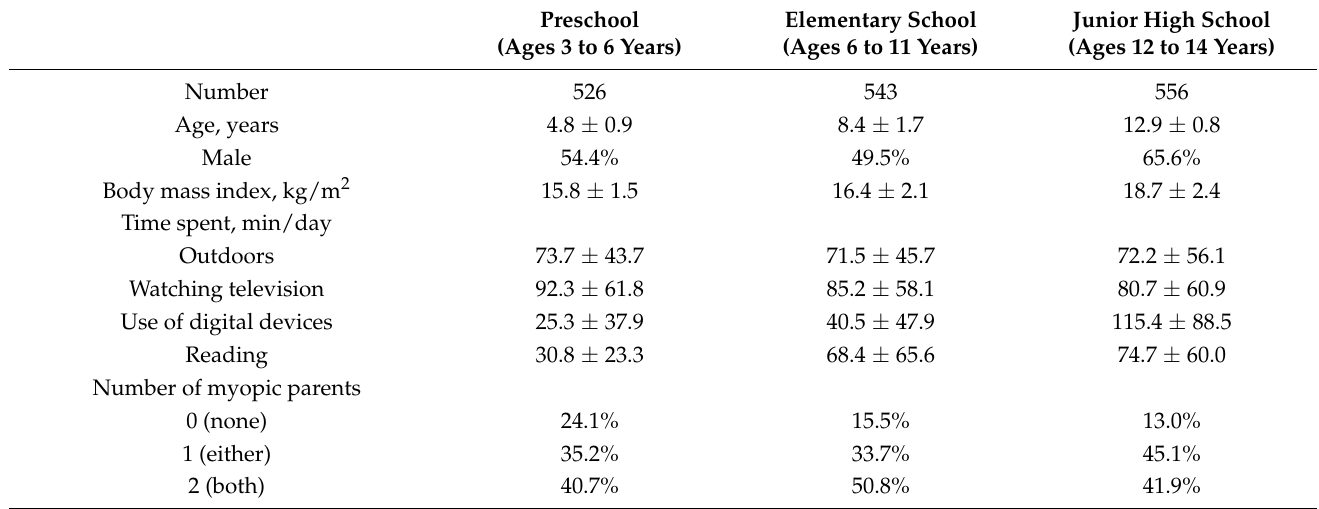
Table 2. Lifestyle characteristics based on school groups.